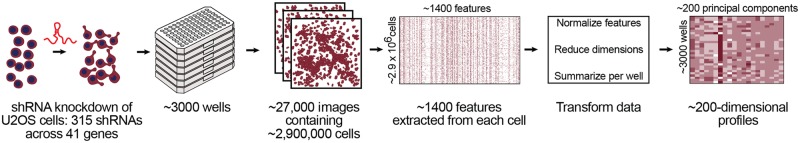
Workflow for generating morphological profiles using Cell Painting.U2OS cells are treated with shRNAs and transferred to 384-well plates in which they are stained and then imaged. The images are analyzed and ~1400 features are extracted from each cell. These data are then transformed to generate multivariate profiles.